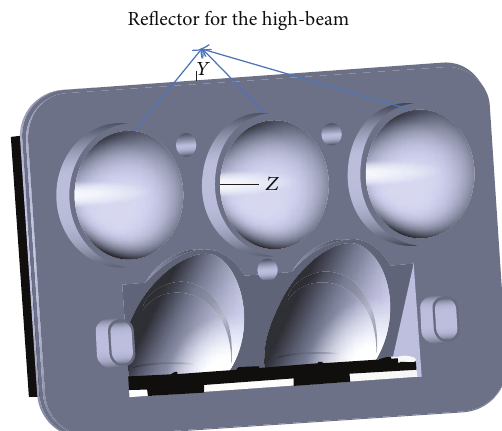
Figure 8: Optical setup in the simulation.